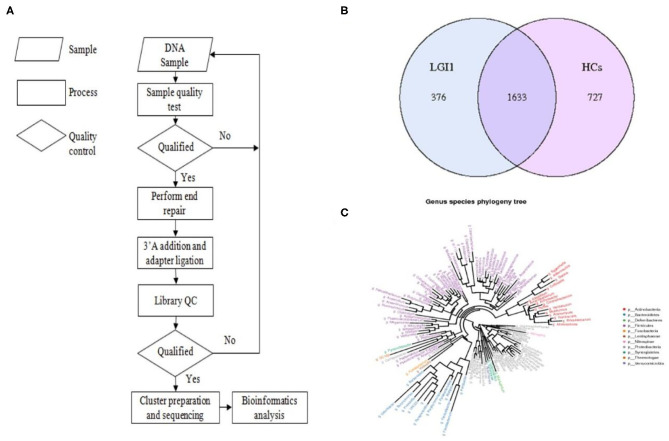
Gut microbial composition differences in anti-LGI1 encephalitis and HCs. (A) Flowchart illustrating the methods. (B) Venn diagram representation of the gut microbiota between anti-LGI1 encephalitis patients and HCs. Operational taxonomical unit. OTUs, 376 and 727, were found to be unique to the anti-LGI1 encephalitis patients and HCs, respectively. The shared OTUs were 1,633, and accounted for 81.3% (1633/2009) and 69.2% (1,633/2,360) in the patient and HCs samples, respectively. (C) Genus-species phylogeny tree of all subjects.